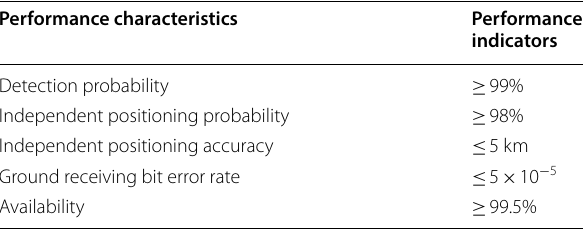
Table 3 Main BDS RSMC Service Performance Indicators Performance characteristics